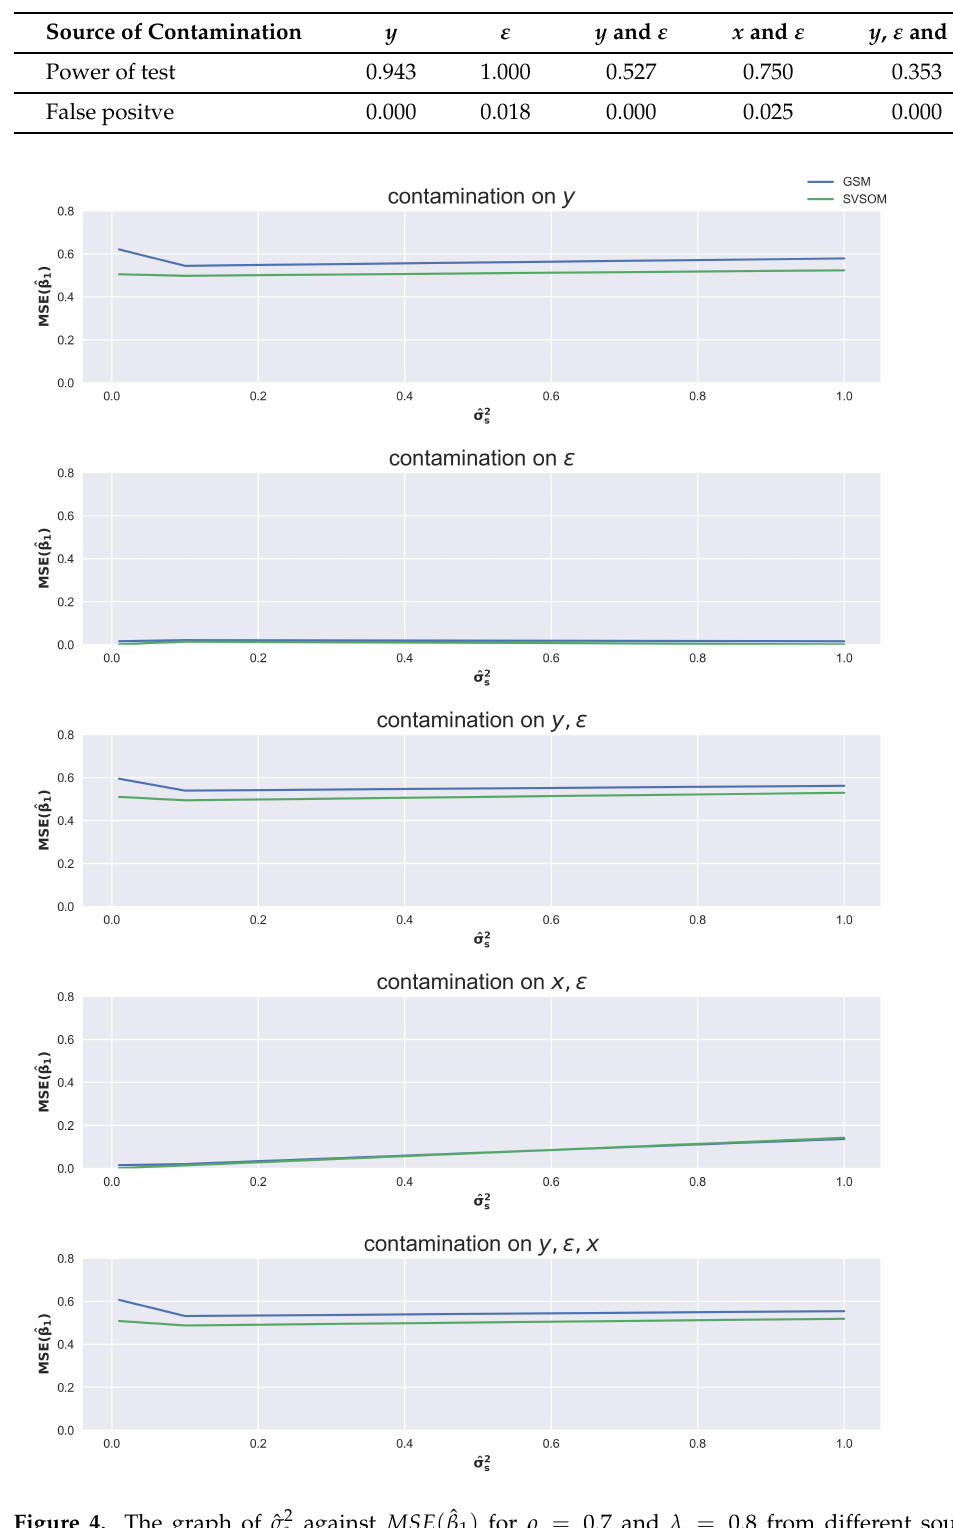
Figure 4. The graph of ˆ σ 2 s against MSE ( ˆ β 1 ) for ρ = 0.7 and λ = 0.8 from different sources of